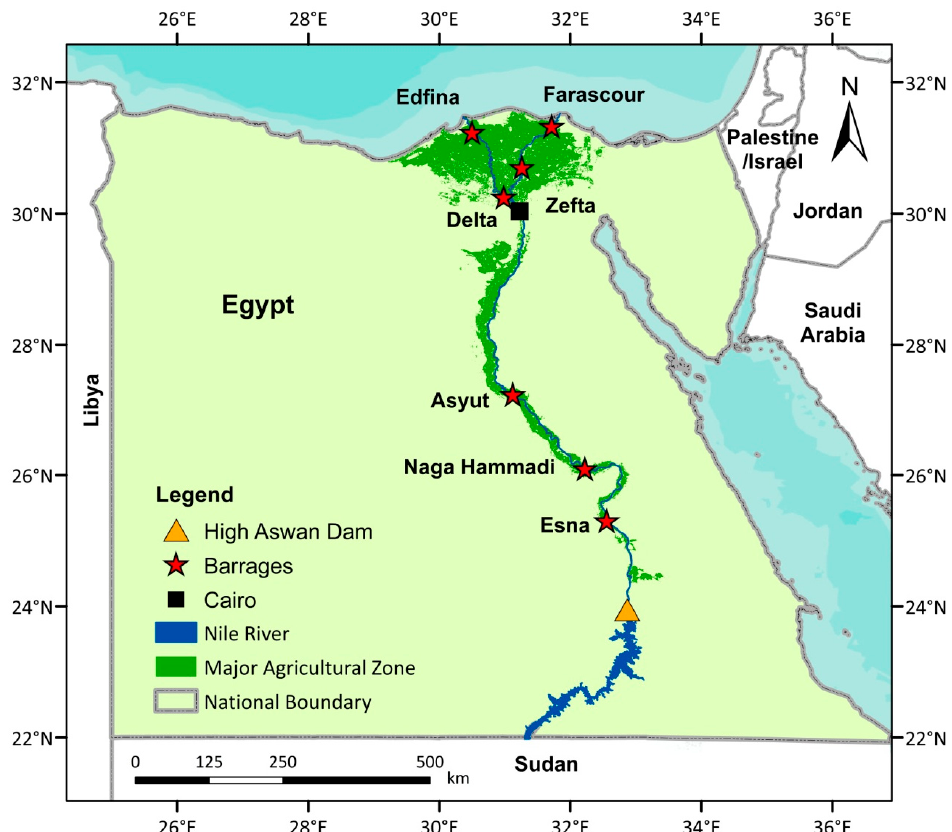
Figure 1. Location map of Egypt illustrating the major agricultural zone and irrigation infrastructure in the Nile Delta and the Nile Valley.